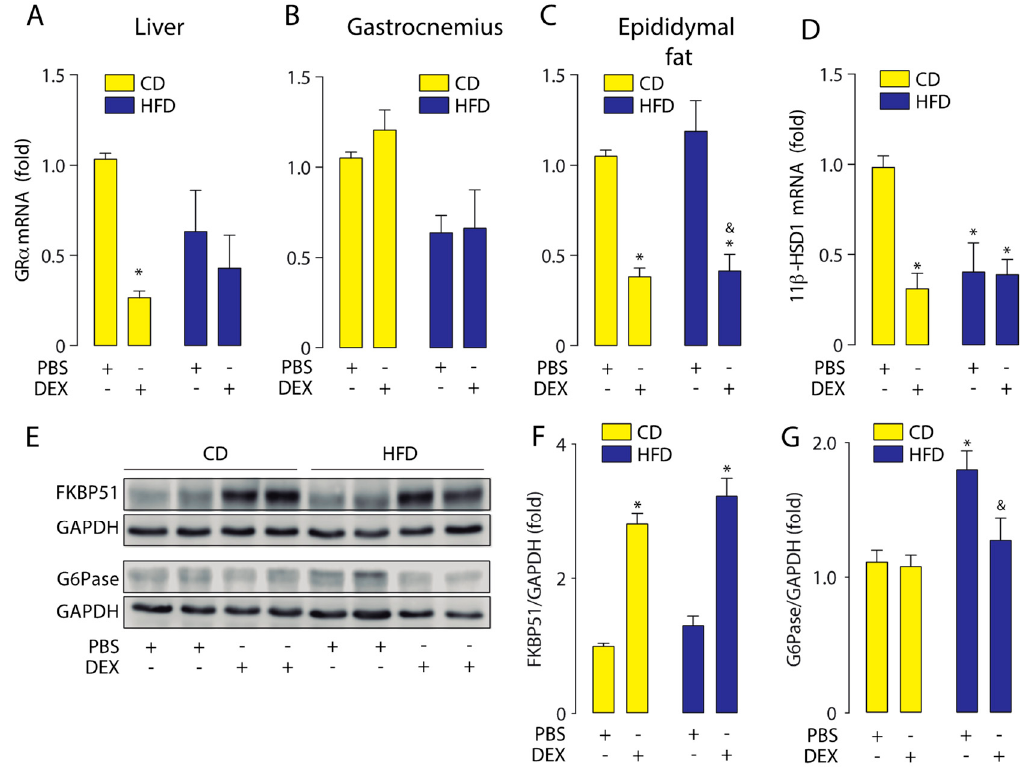
Figure 6. Moderate aerobic training prevented the high-fat diet-increased glucocorticoid receptor response. Glucocorticoid receptor α (GR α ) and 11 β -hydroxysteroid dehydrogenase type 1 (11 β -HSD1) mRNA levels were determined by qPCR in the liver, gastrocnemius, and epididymal fat obtained from high-fat diet (HFD) or control diet (CD) mice subjected to moderate anaerobic training and treated with a dexamethasone injection (DEX; 2 mg / Kg i.p.) or phosphate-bu ff ered saline (PBS). FK506-binding protein 51 (FKBP51) and glucose-6-phosphatase (G6Pase) protein levels were assessed by Western blotting. Glyceraldehyde-3-phosphate dehydrogenase (GAPDH) was used as a loading control. ( A ) GR α mRNA expression in the liver. ( B ) GR α mRNA expression in the gastrocnemius. ( C ) GR α mRNA expression in epididymal fat. ( D ) 11 β -HSD1 mRNA expression in the liver. ( E ) Representative Western blot image. ( F ) Liver FKBP51 protein levels. ( G ) Liver G6P protein levels. n = 6 mice per